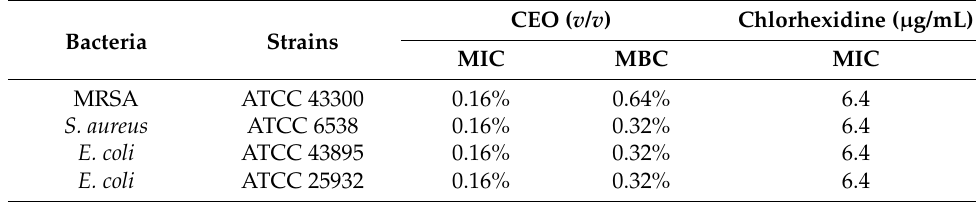
Table 2. Antibacterial activities of CEO.